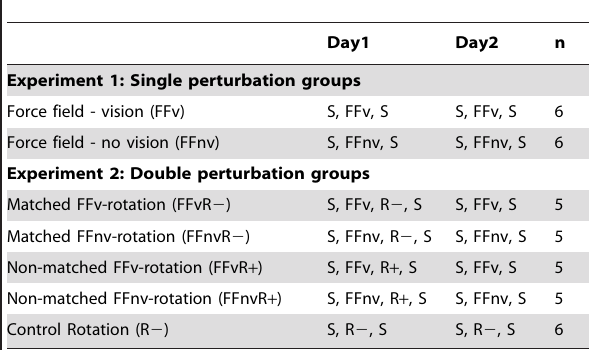
Table 1. Experimental groups and block